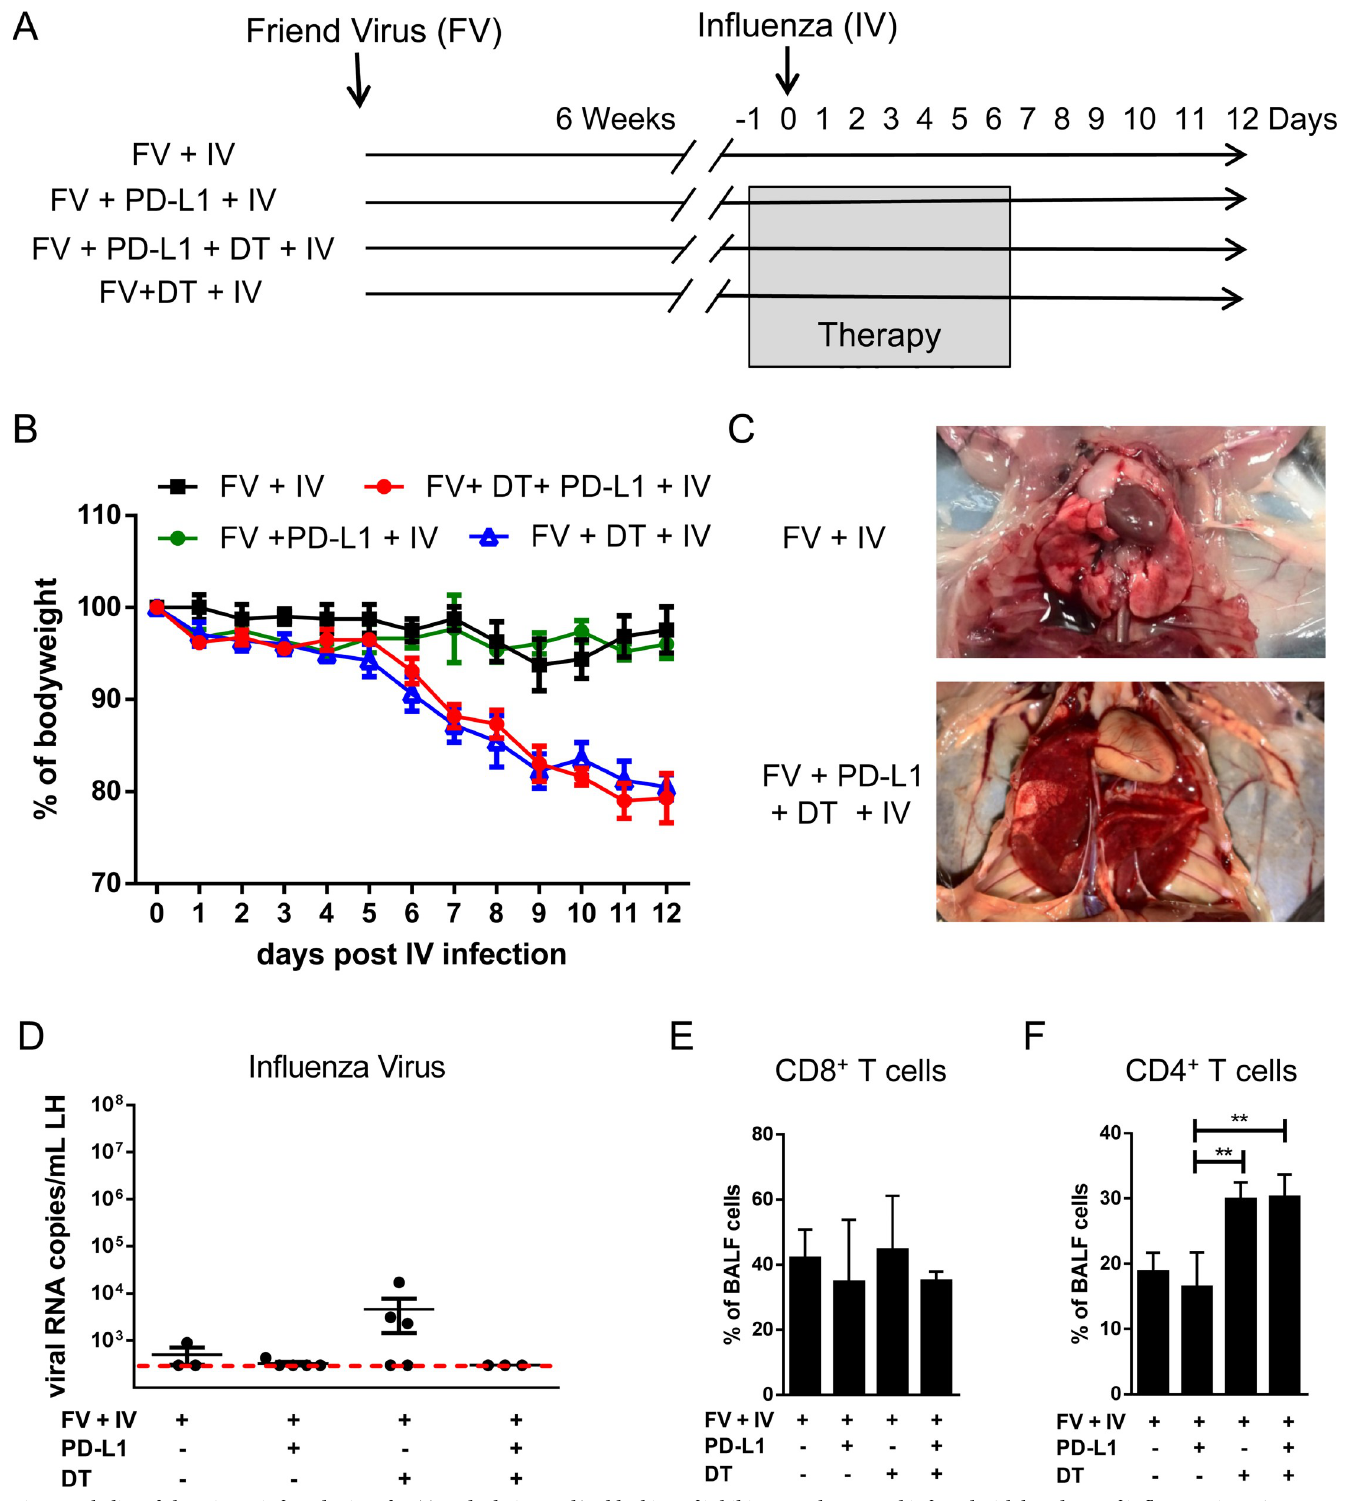
Fig 5. Lethality of chronic FV infected mice after Treg depletion and/or blocking of inhibitory pathways and infected with low doses of influenza virus. A . Chronically FV infected mice were treated with DT for Treg depletion and/or treated with anti-PD-L1 antibody. One day after starting the treatment mice were infected with IV. The weight of the analyzed group of mice ( B ) and the lungs of non-treated and combination treated mice ( C ). The numbers of RNA copies of IV in lung homogenate ( D ). The dashed line reflects the detection limit of the method. The percentage of CD4+ ( E ) and CD8+ ( F ) T cells in the BALF cells was calculated by